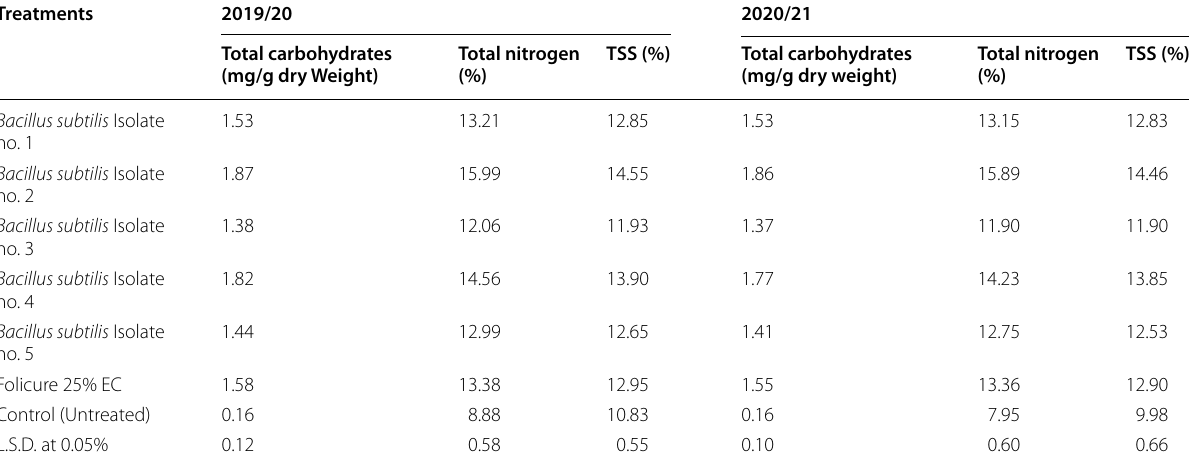
Table 5 Effect of Bacillus subtilis and Folicure treatments on chemical components of yielded dry onion bulbs at the end of the